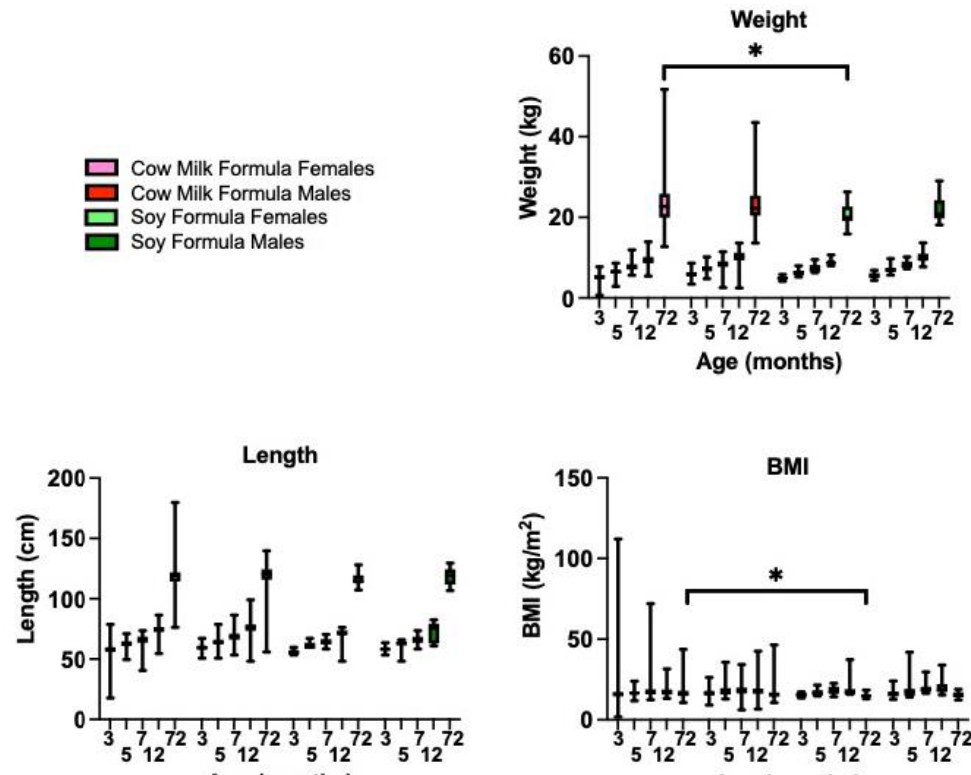
Figure 3. Infant feeding during the first 3 months of life is associated with growth metrics and adverse outcomes in children at 6 years of age. Growth cohorts included females fed cow milk formula ( n = 240), males fed cow milk formula ( n = 215), females fed soy formula ( n = 15), and males fed soy formula ( n = 21). Statistics were determined by two-way ANOVA with mixed-effects analysis for body weight (age p < 0.0001, diet p = 0.0124, sex p = 0.0049, age x diet p = 0.0010, age x sex p = 0.9733, diet x sex p = 0.3370, and age x diet x sex p = 0.4498); body length (age p < 0.0001, diet p = 0.0134, sex P = 0.0059, age x diet p = 0.8580, age x sex p = 0.9953, diet x sex p = 0.7330, and age x diet x sex p = 0.9936); BMI (age p < 0.0001, diet p = 0.7892, sex p = 0.1773, age x diet p = 0.0861, age x sex p = 0.7547, diet x sex p = 0.4810, and age x diet x sex p = 0.9901). Statistical significance for age-matched comparisons is denoted by p < 0.05 (*).